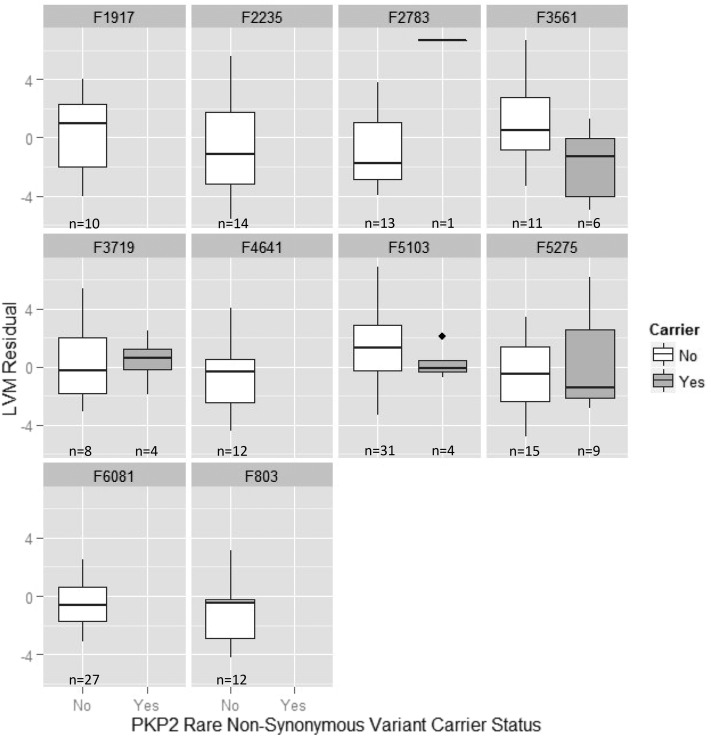
Box and whisker plots showing the distribution of LVM residual by PKP2 nonsynonymous rare variant carrier status, stratified by family. LVM residuals were calculated by adjusting for sex, body mass index (BMI), systolic blood pressure, and smoking status. Carriers of a PKP2 nonsynonymous rare variant are shown in gray and noncarriers are shown in white.